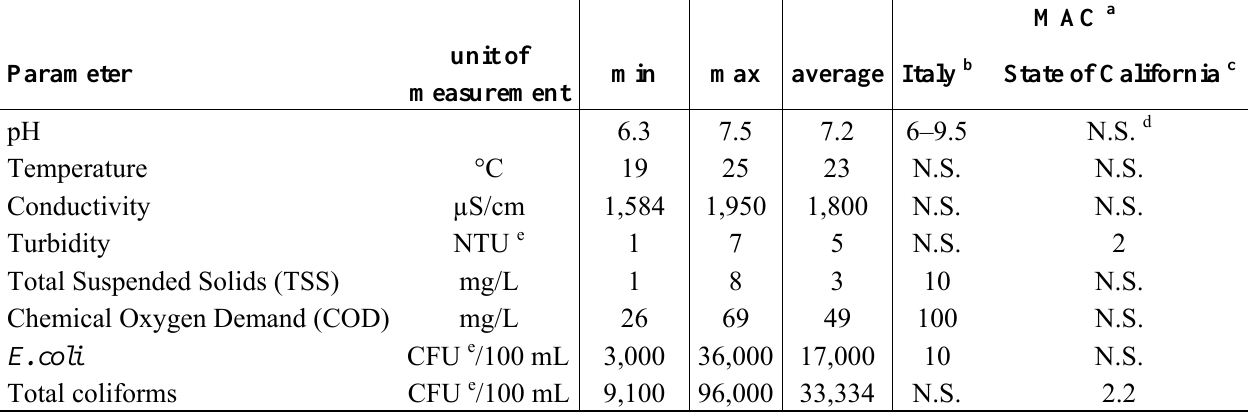
Table 2. Characteristics of the secondary settled effluent (SSE) coming from the City of Taranto (South Italy) Municipal Wastewater Treatment Plant